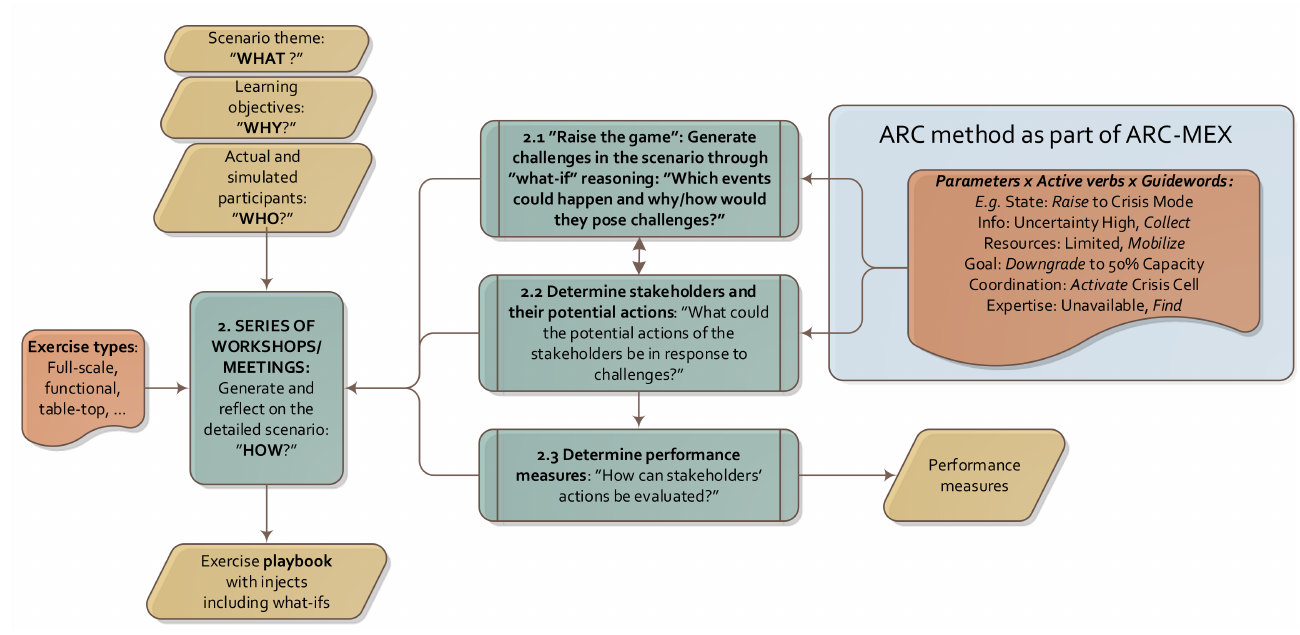
Figure 2. A detailed overview of steps and products of step 1 in the ARC-MEX